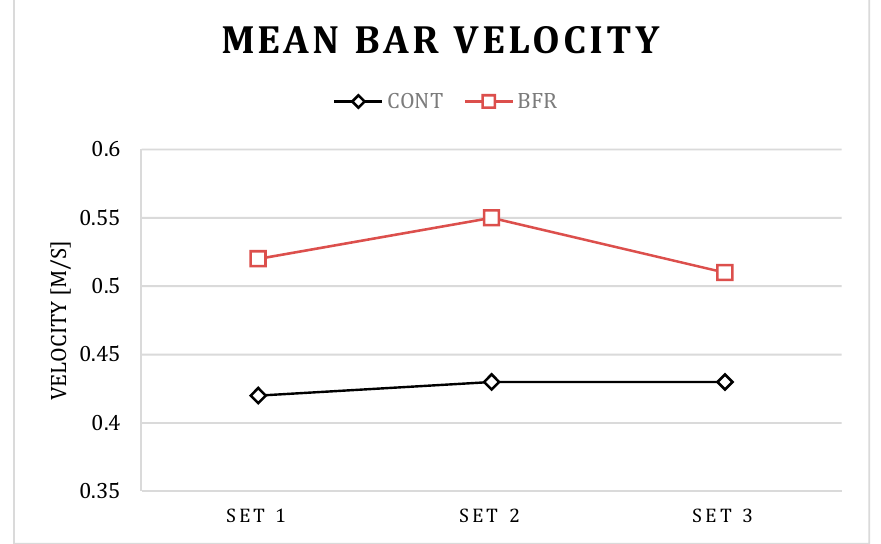
Figure 2. Peak power output for the BFR and CONT conditions during three successive sets of the bench press exercise.